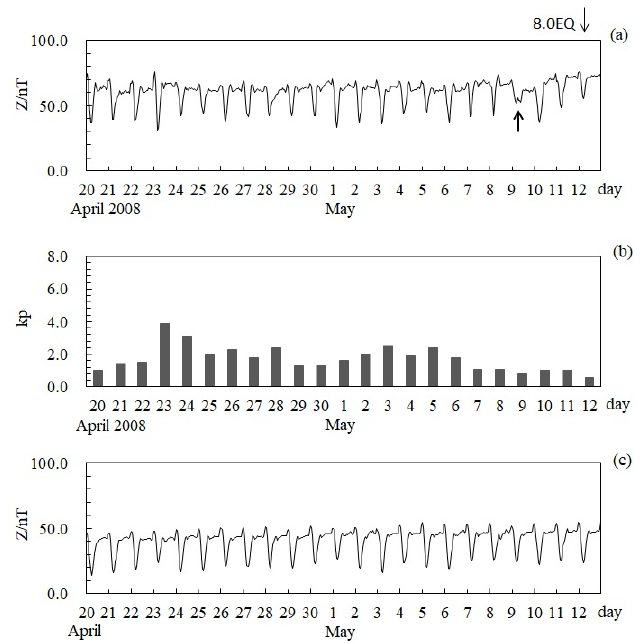
Figure 6. Daily changes of the geomagnetic vertical Z at the CD station and Kp-index. ( a ) Daily vertical Z fluctuations from 20 April to 12 May 2008. The unusual fluctuation on 9 May is labeled by a black arrow and the Wenchuan 8.0 EQ is also labeled. ( b ) Daily average Kp-index fluctuations from 20 April to 12 May 2008. ( c ) Average daily vertical Z fluctuations during the period of 2009–2016 from 20 April to 12 May (adapted from [51]).